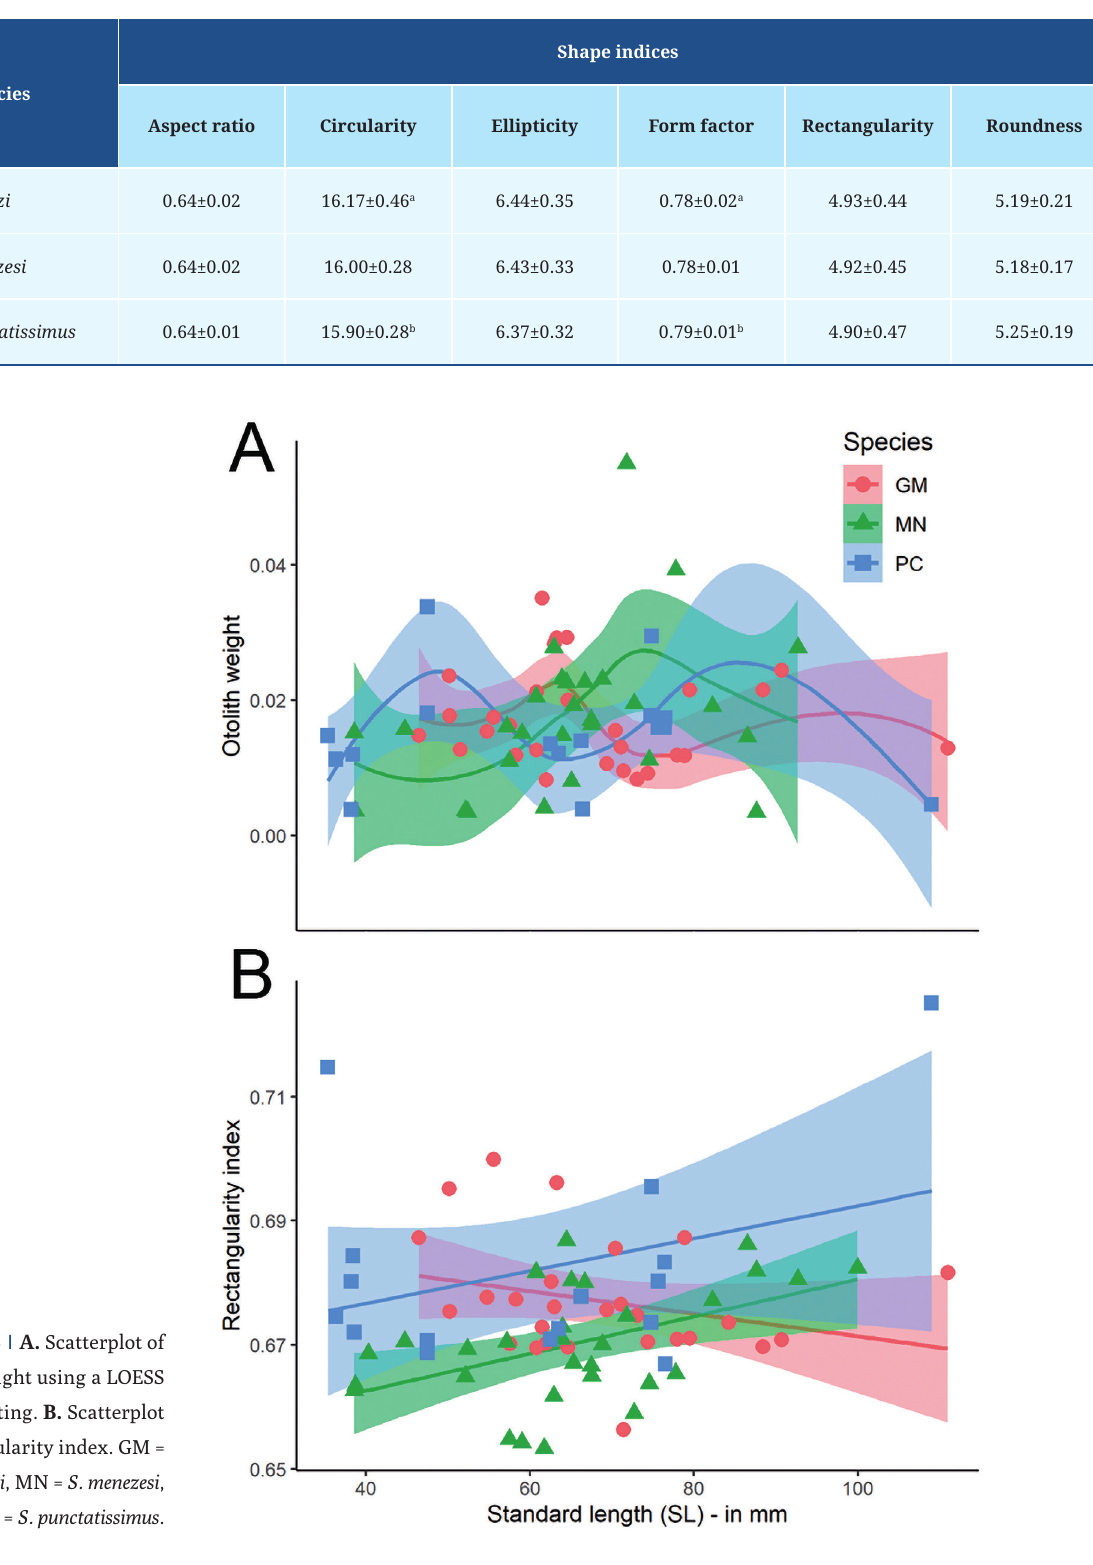
TABLE 2 | Values of shape indices by species in the Stellifer punctatissimus complex. Different letters show significant differences (p < 0.05), using ANOVA and Tukey’s post hoc